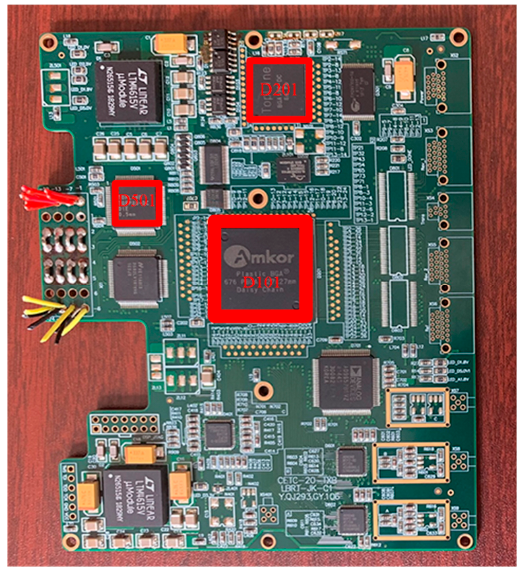
Figure 1. Details of the